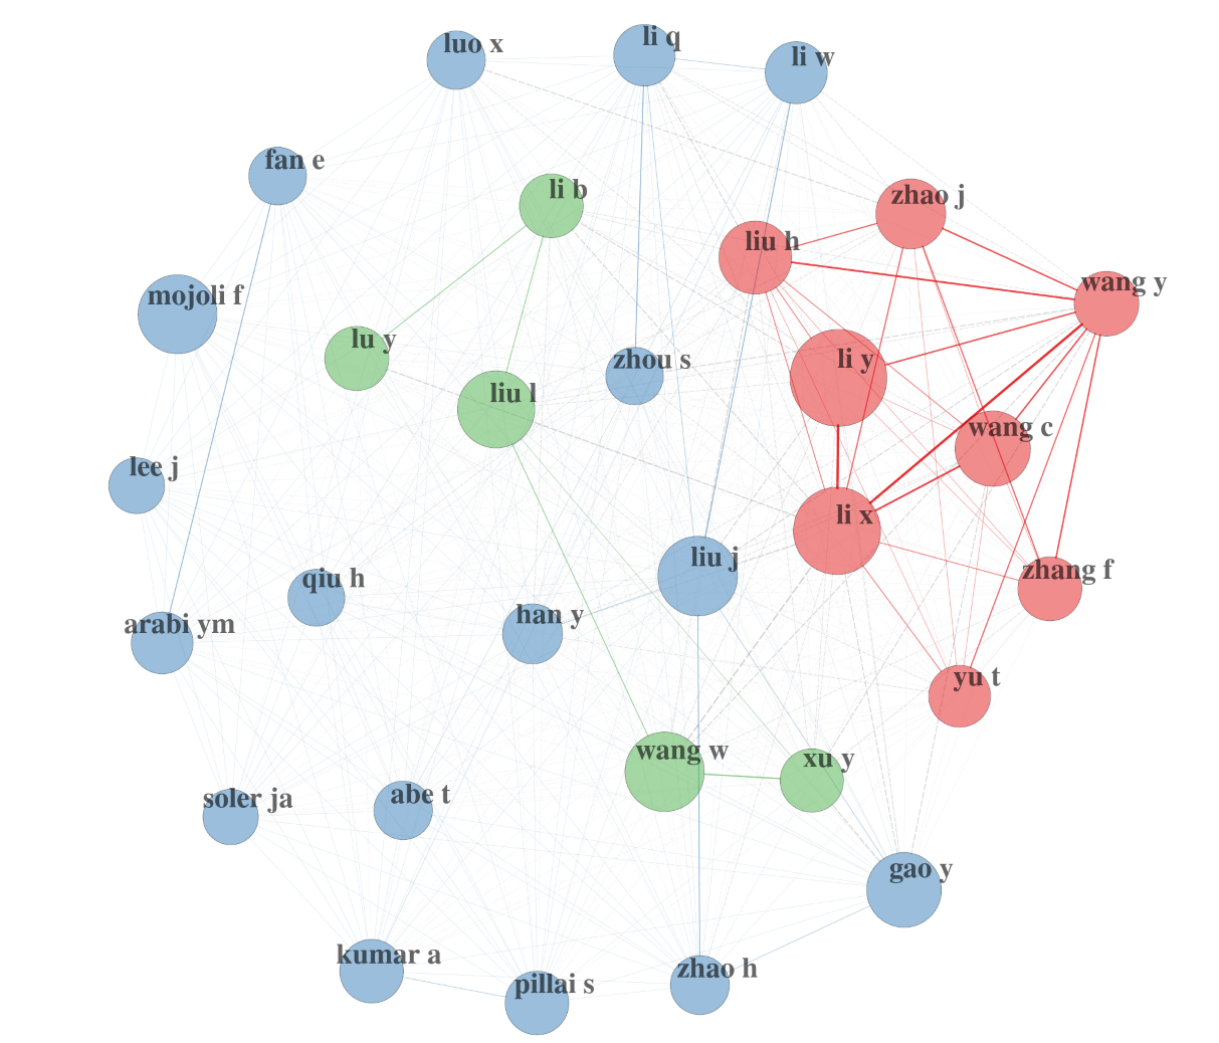
Figure 4. Author collaboration